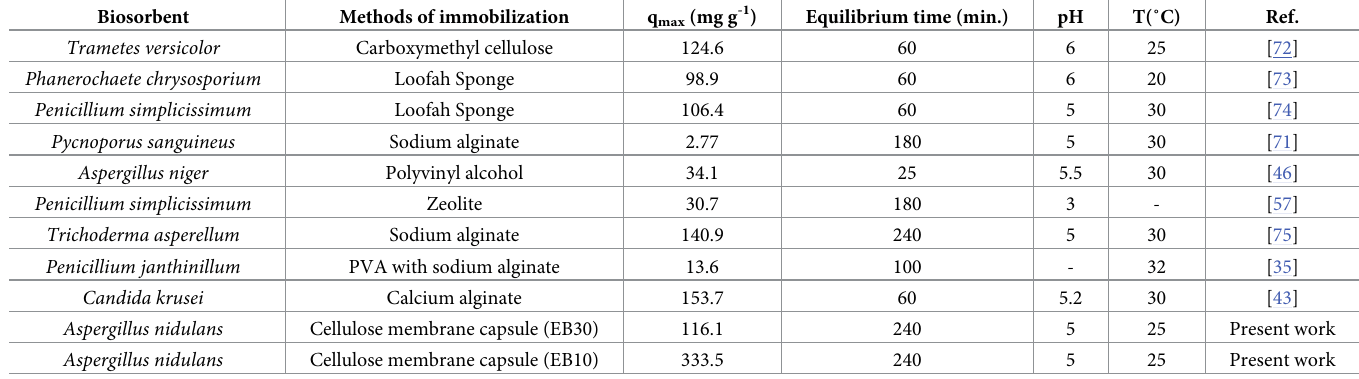
Table 3. Comparison between the maximum biosorption capacities (q max ) predicted by the Langmuir model for copper ions by encapsulated biosorbent (EB10 and EB30) in relation to other immobilized fungal biosorbents.